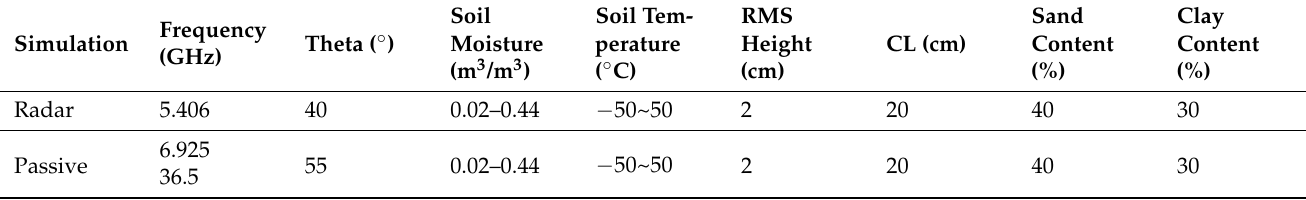
Table 4. Input parameters in the simulation of the radar backscattering coefficient and passive microwave Tb. RMS height indicates root mean square height. CL means correlation